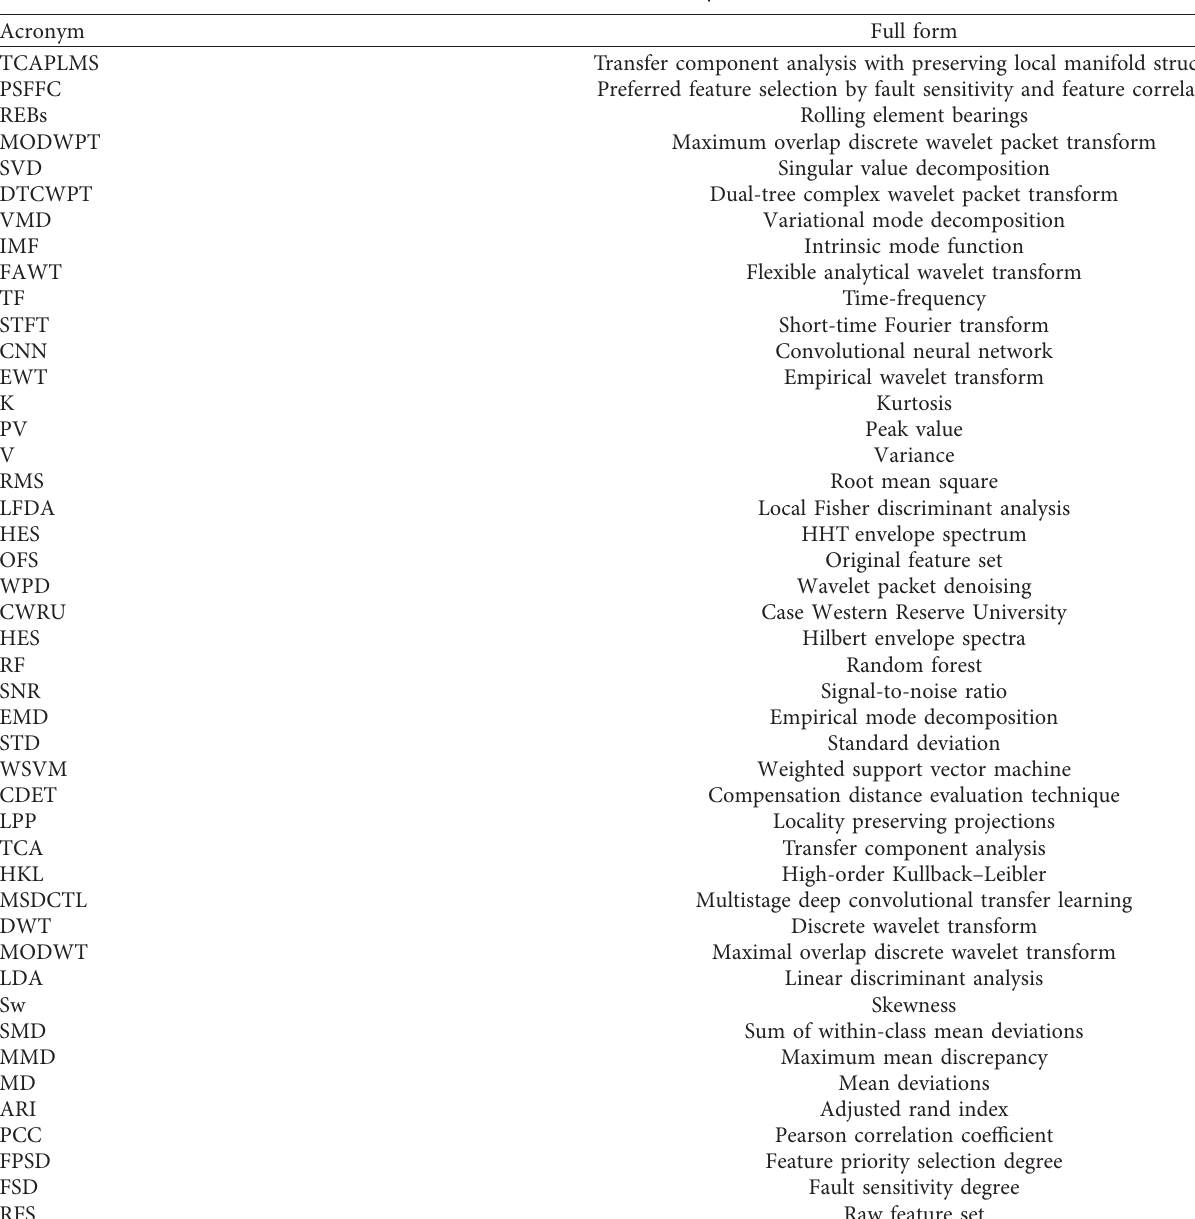
Table 1: A list of